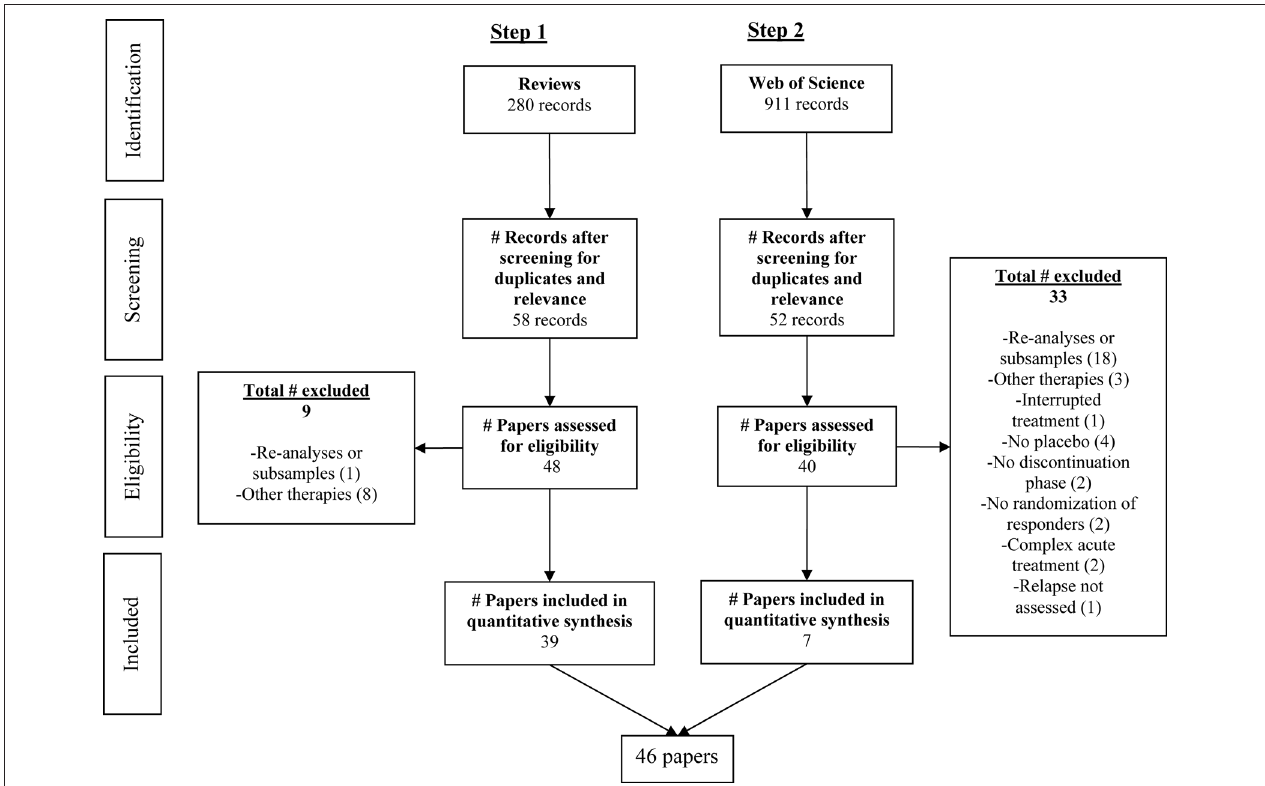
FiguRE 1 | Flow diagram of the search strategy.